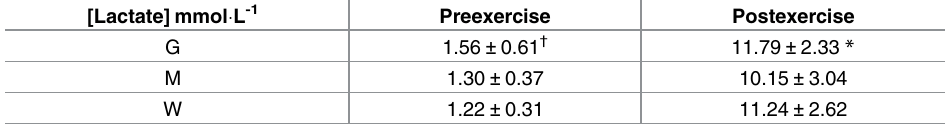
Table 3. Capillary blood lactate levels recorded in the 3 different CrossFit modalities in the 34 partici- pants (M ±